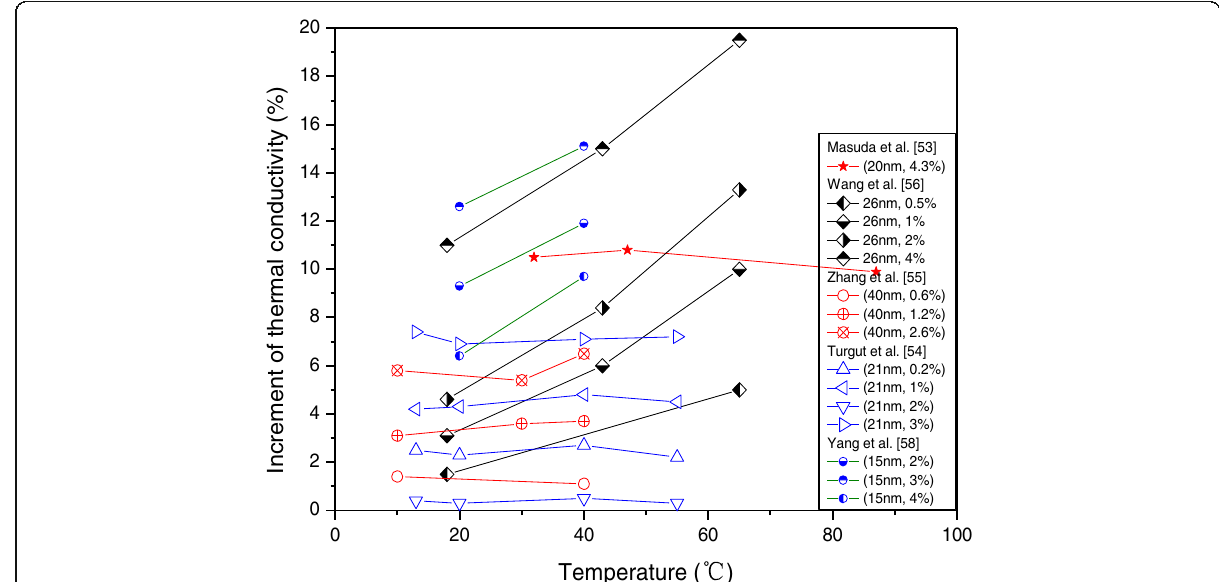
Fig. 2 Influence of temperature on the enhancement of thermal conductivity of TiO 2 nanofluids in different